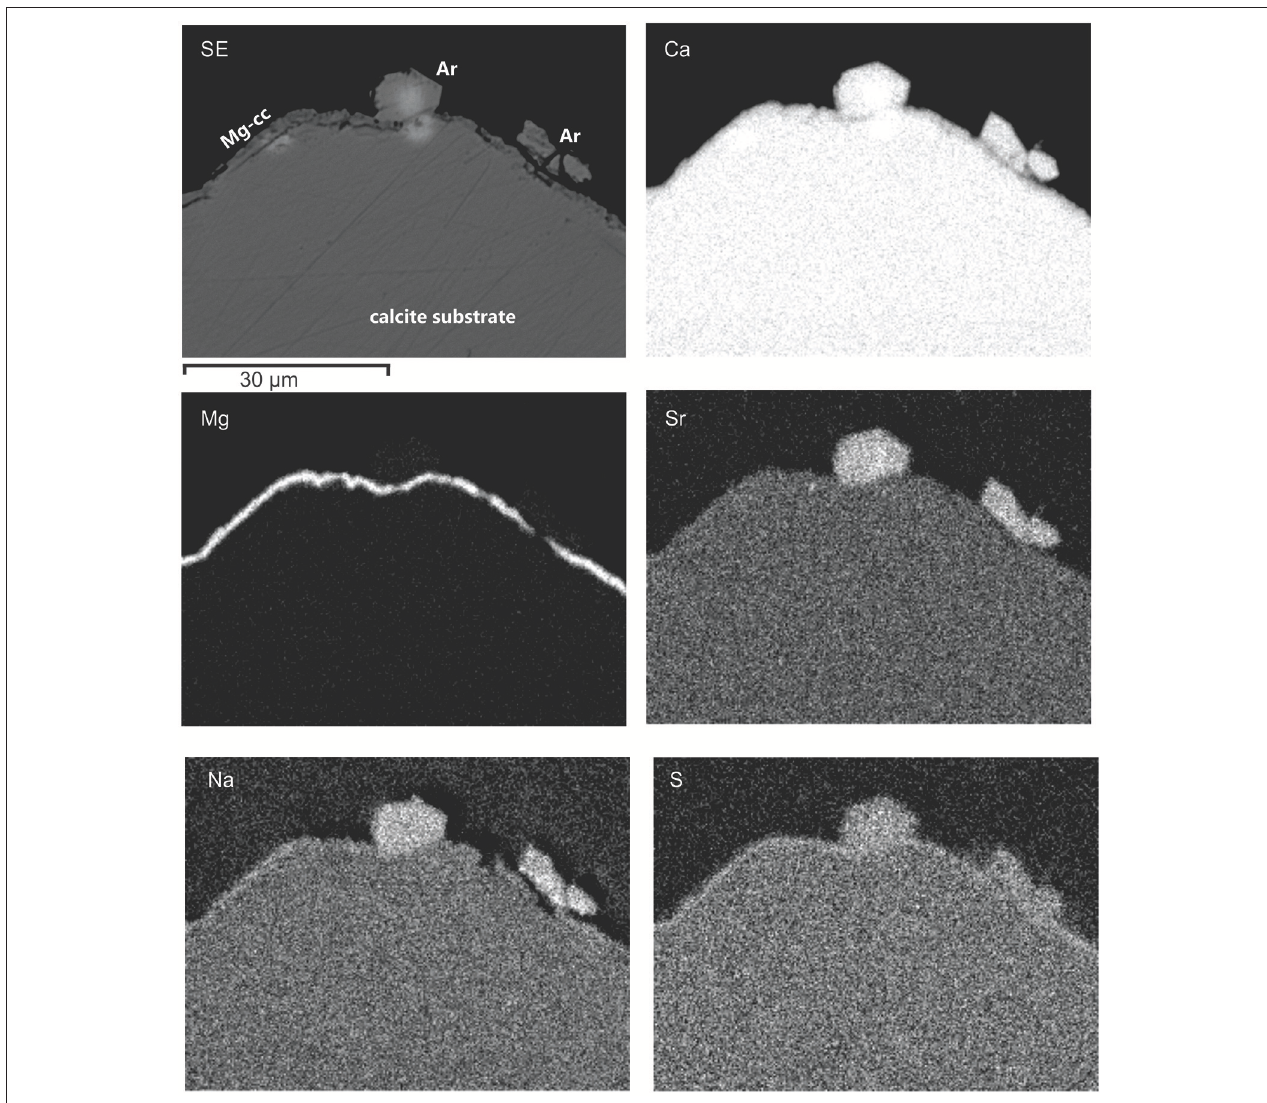
FIGURE 2 | SE image and EDS elemental maps of Ca, Mg, Sr, Na, and